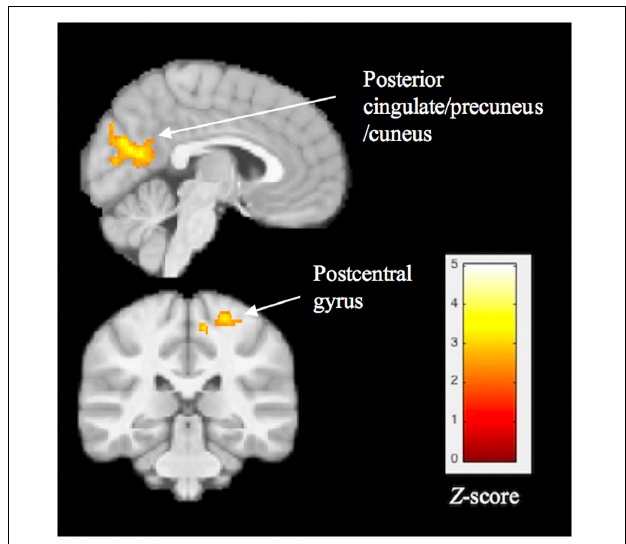
FIGURE 3 | Significant group differences in task-related functional connectivity of the left fusiform gyrus, assessed using psychophysiological interaction analysis. Compared with healthy controls, youth with BD showed lower connectivity between the fusiform cluster and 3 regions: posterior cingulate, precuneus/cuneus, and postcentral gyrus. Thresholds were set at p < 0.05, FWE corrected at the cluster level.